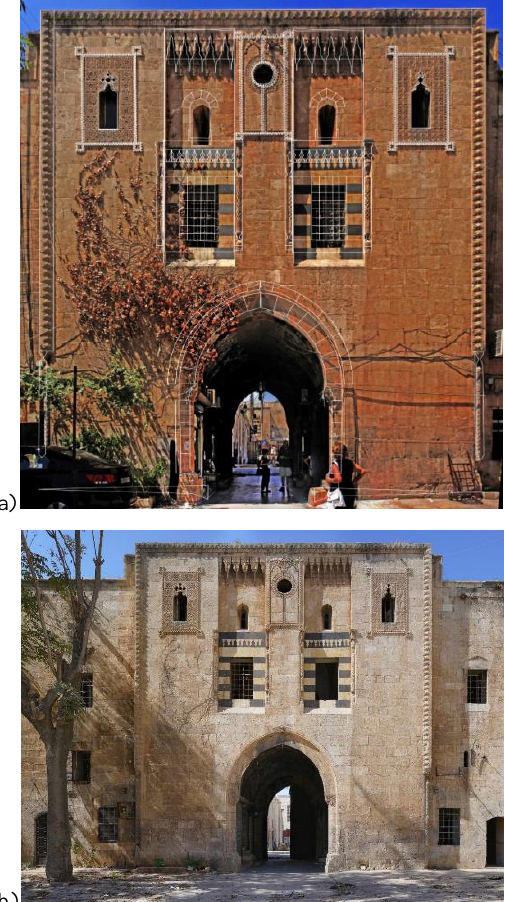
Figure 3. Khan el wazir, caravan-serray in the typical ablaq style, as it was (a) and as it is now (b). The difference in colour is very much evident, probably due to the limestone dust.